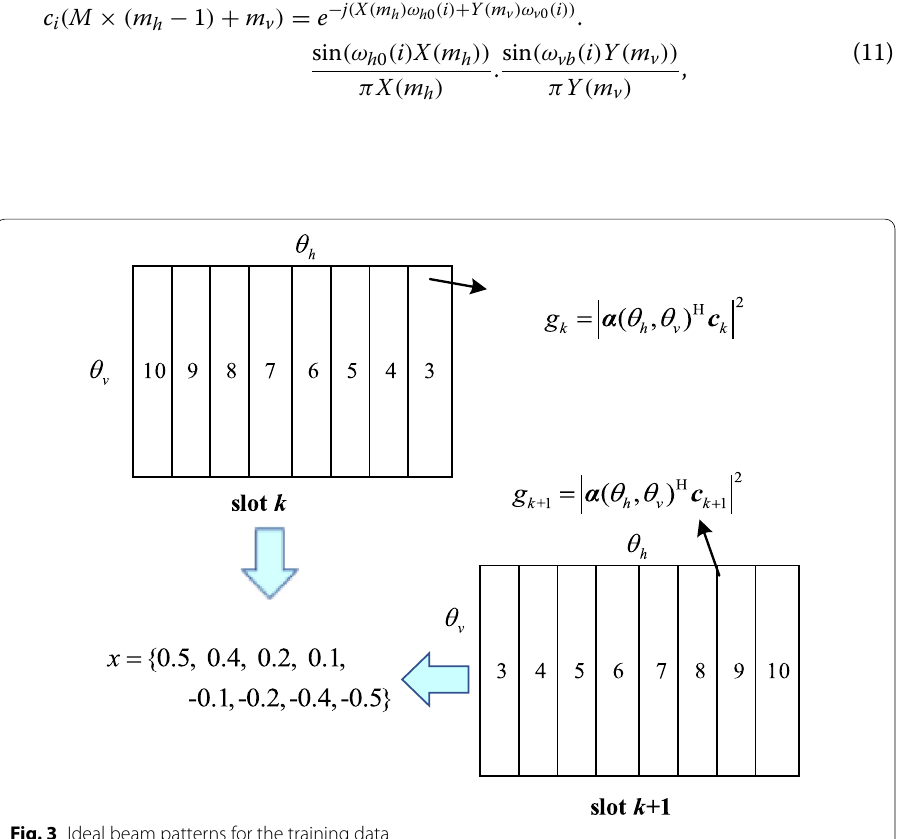
Fig. 3 Ideal beam patterns for the training